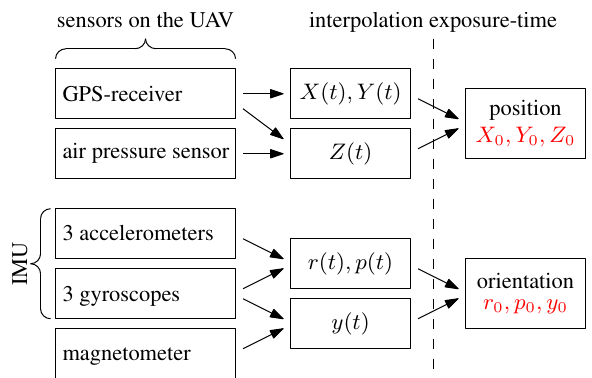
Figure 3: Direct georeferencing of the images by integration of all available sensors on board of the UAV.